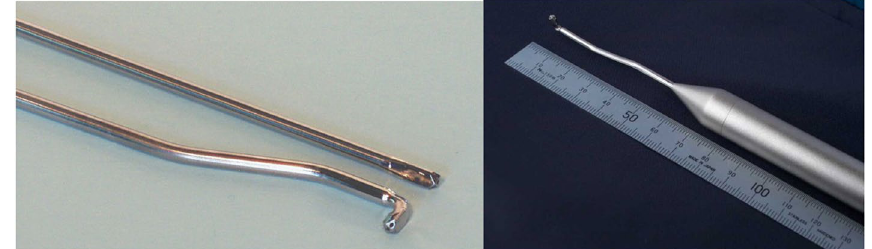
Fig. 6 4-hole cobra probe manufactured and calibrated by Turbulent Flow Instruments (http:// www. turbu lentf ow. com.